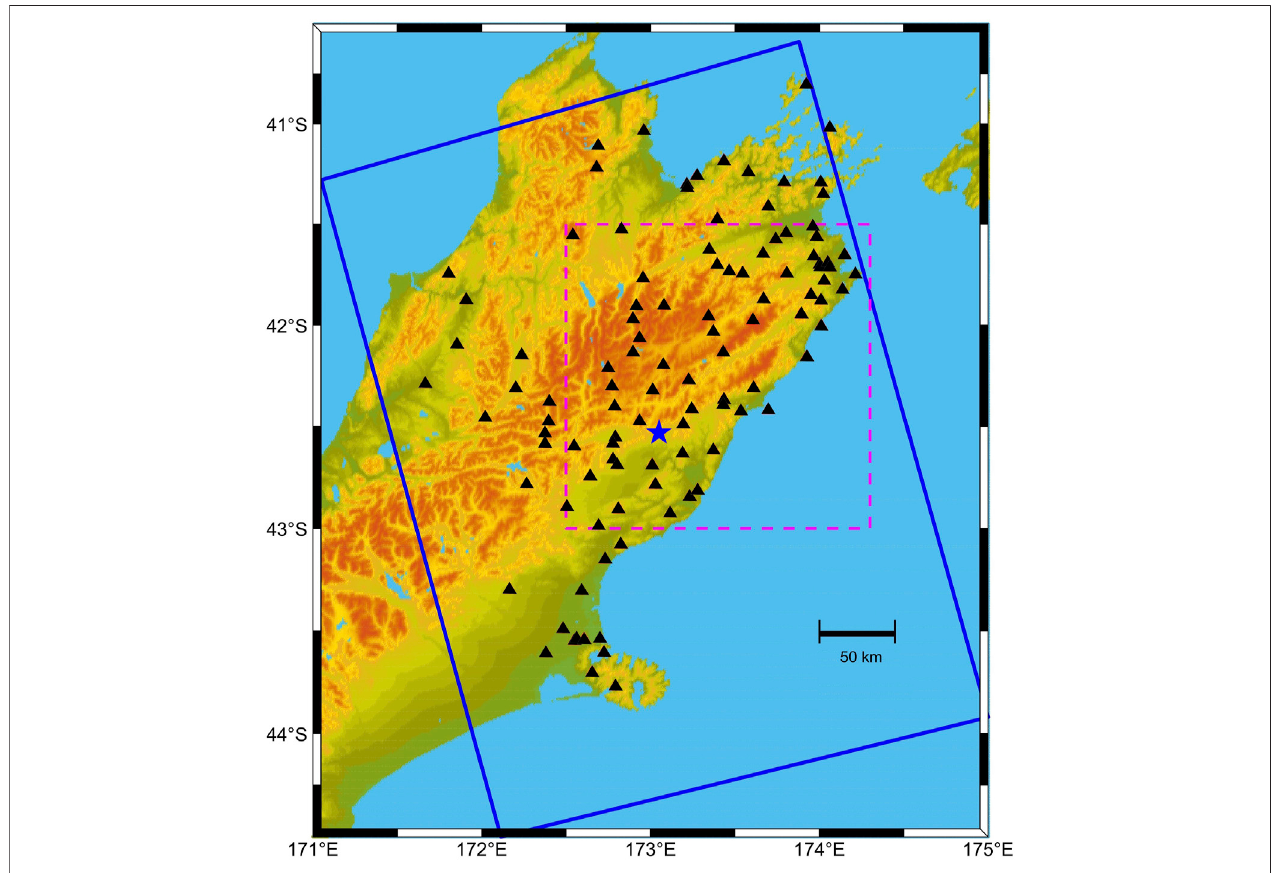
FIGURE 2 | Color-shaded relief map of central New Zealand. The blue box indicates the coverage of the Sentinel-1A SAR imagery. The dashed magenta box shows the location of our study area for this study. The black triangles show GPS sites. The blue star in the middle denotes the epicenter of the Kaik ō ura earthquake.